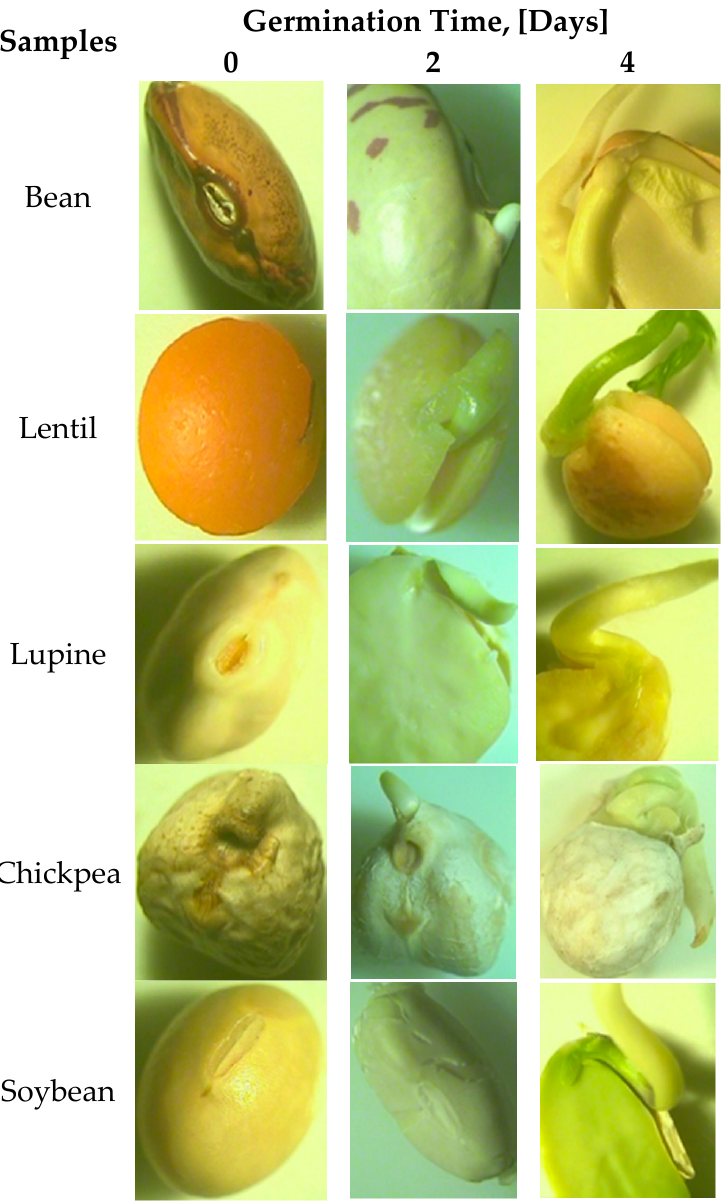
Figure 1. Stereomicroscope images of legumes during germination.